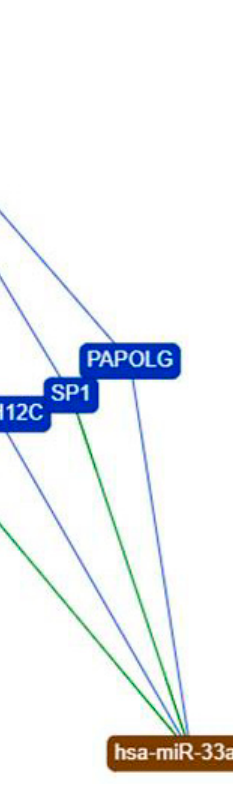
Figure 1. Investigation of osteoblasts (OB) and chondrocytes (CH) isolated by tissue debris of mild OA and severe OA patients through qRT-PCR expression analysis of ( A ) miR-31-5p and miR-33a-5p; ( B ) miR-31-5p OB targets genes: RHO and HIF-1AN; and ( C ) miR-33a-5p CH targets genes: COL2A1 and HMGA2. Quantitative RT-PCR data are expressed as fold of change (FOI) in miRNAs or gene expression (2- ΔΔ Ct ) occurred in severe OA-derived cells vs mild OA-derived cells. Data reported were analysed by Student t test: *, p < 0.05, **, p < 0.005, ***, p < 0.0005 between experimental group and represented as mean ± SD ( n = 4).